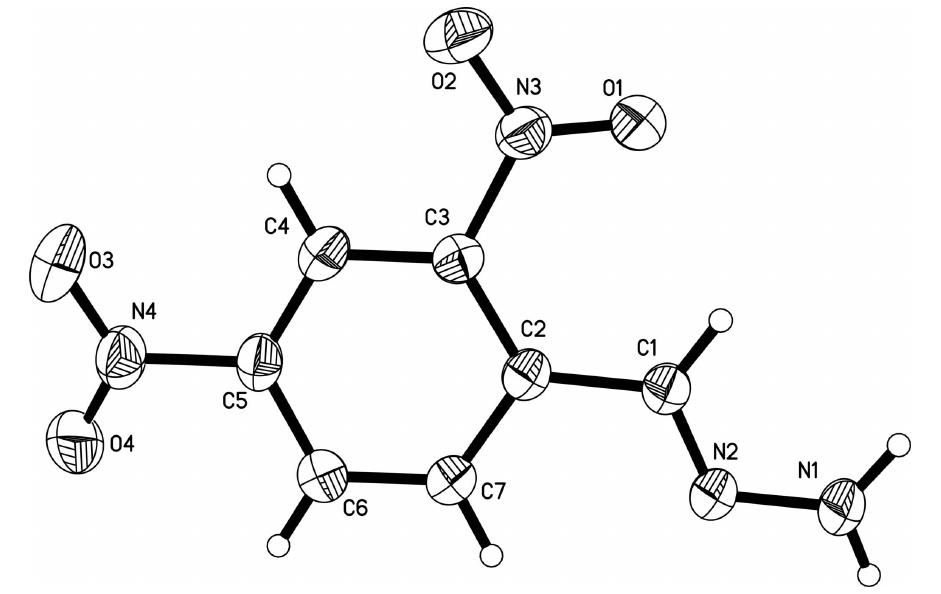
Figure 1 Perspective drawing of the title compound, with the atomic numbering scheme. Displacement ellipsoids are shown at the 35% probability level.